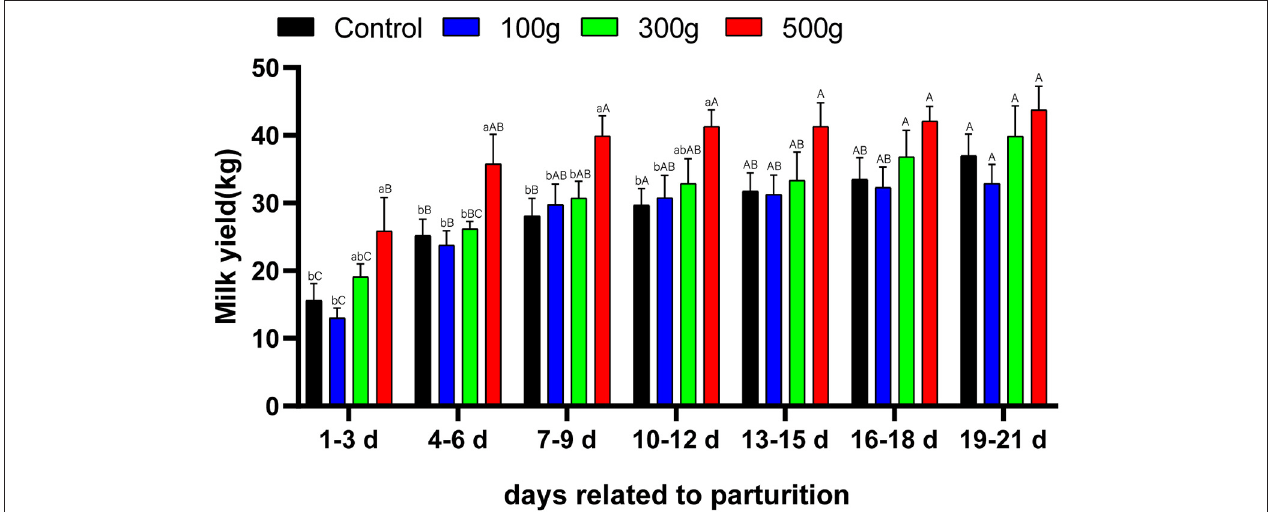
FIGURE 1 | Effects of dietary TCMF4 on milk production in peripartal dairy cows. Milk was collected during the 3-d metabolic measurements for each period. Daily averages are represented. The control group was fed a basic diet: TCMF4 groups (control diet supplemented with TCMF4). a,b Different superscripts within a row represent significant differences between groups ( P < 0.05). A,B Different superscripts in the rows represent significant differences in time ( P < 0.05).